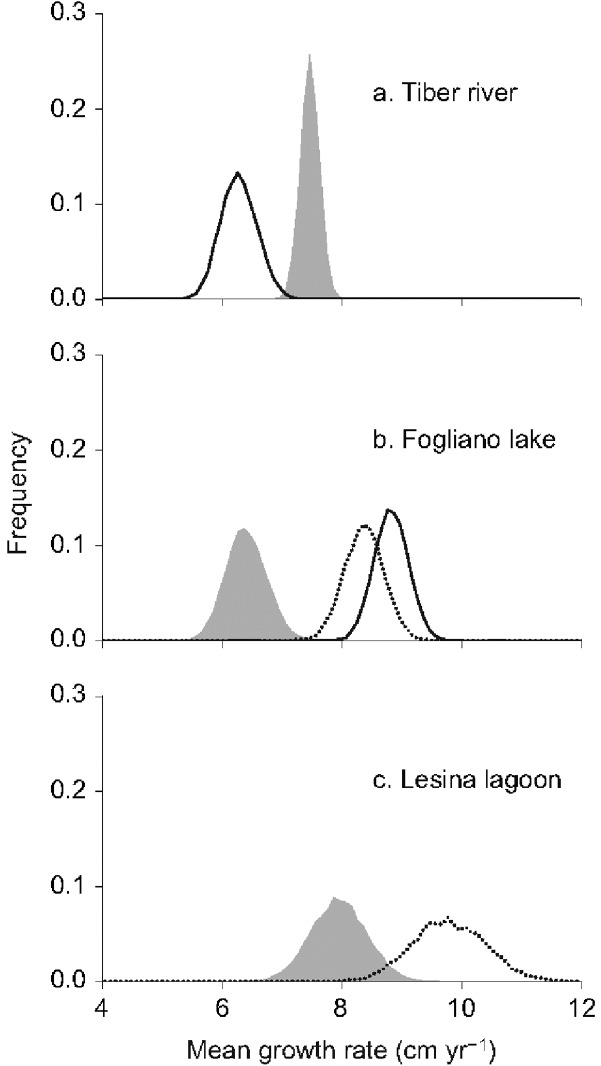
Figure 2. Growth rate distribution of sub-adults, silver males and silver females. Empirical bootstrap distribution of body growth rate (population mean) between age 1 and 3 of sub-adult European eels (shaded areas), silver males (solid lines) and silver females (dotted lines) sampled at three Mediterranean sites: a Tiber river, b Fogliano lake and c Lesina